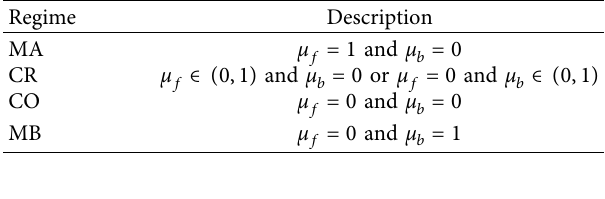
Table 2: Description of control regimes based on μ Regime